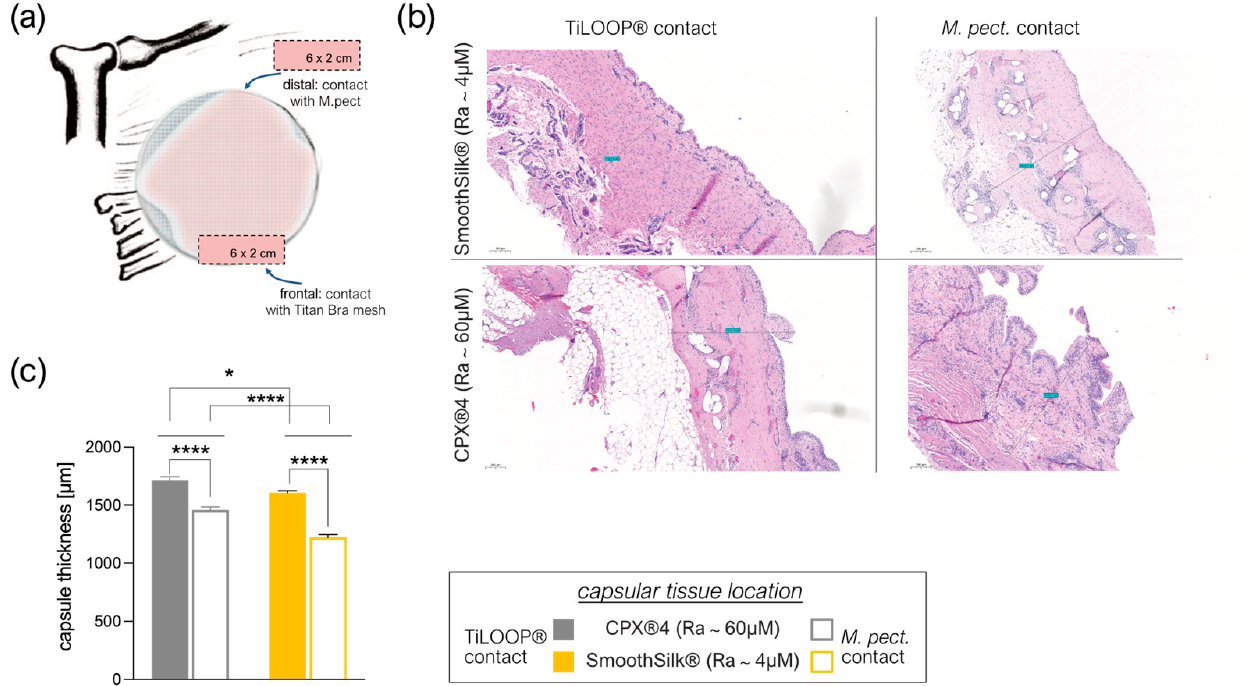
Figure 7. The thickness of the capsule formed around tissue expanders 6-8 months after bilateral tissue expander-based breast reconstruction. ( a ) Sample collection scheme for histological analysis of capsular thickness. ( b ) Hematoxylin and eosin stain of post-operative collected capsular tissue. ( c ) The thickness of the capsule of 7 patients was determined bilaterally in 2 biological replicates and 2 measurements per trial. Mean ± SEM of 7 patients in 7 independent experiments is shown. Statistical significance was determined by 2-way ANOVA: Capsular harvest position (contact